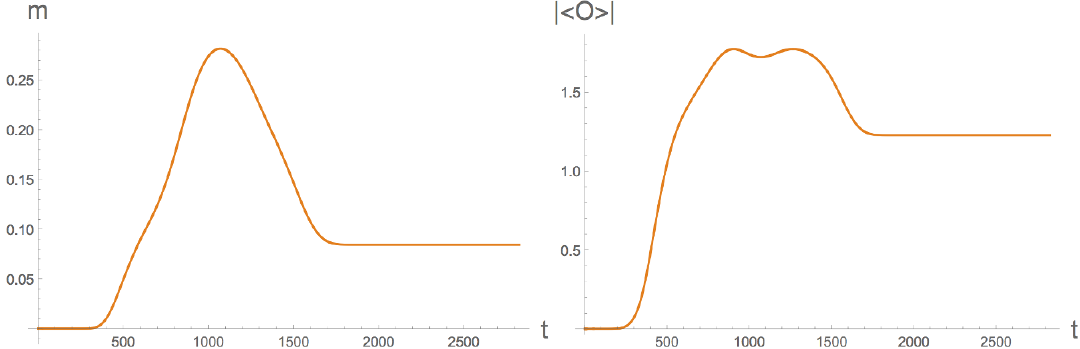
Figure 20 . m and jhOij for the quench process described in the main text. After the quench, both functions (approximately) relax to their values in the boson star solution corresponding to ! f = 2 : 9.